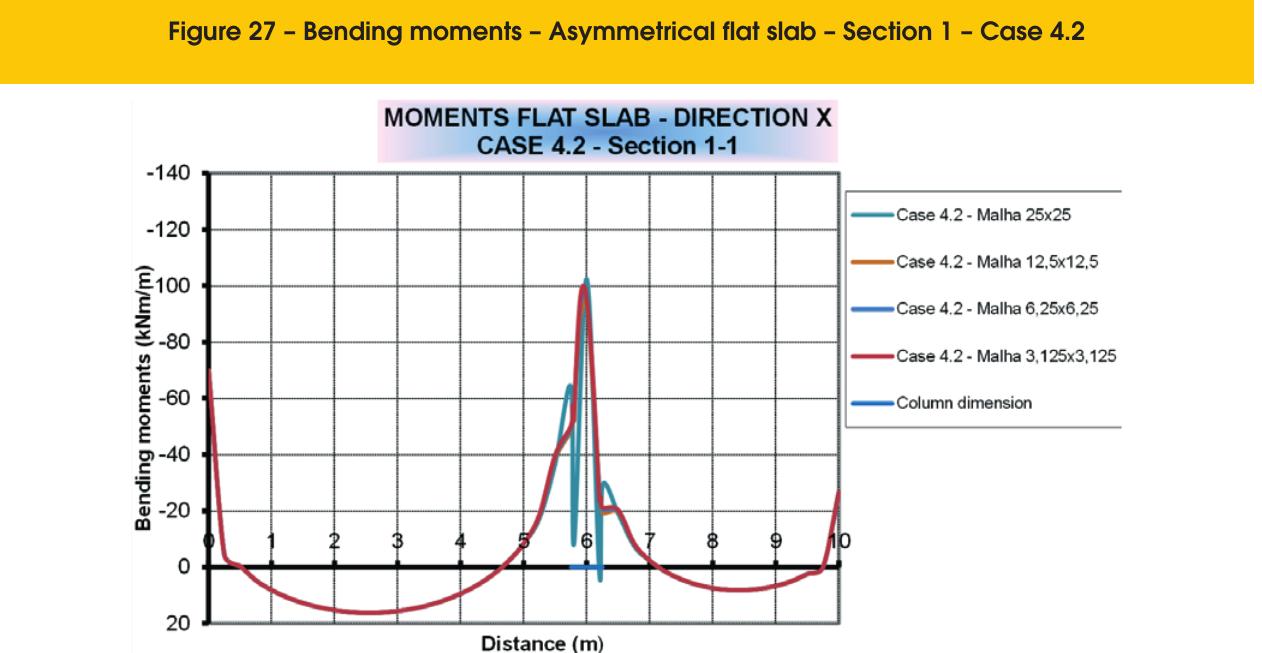
Figure 27 – Bending moments – Asymmetrical flat slab – Section 1 – Case